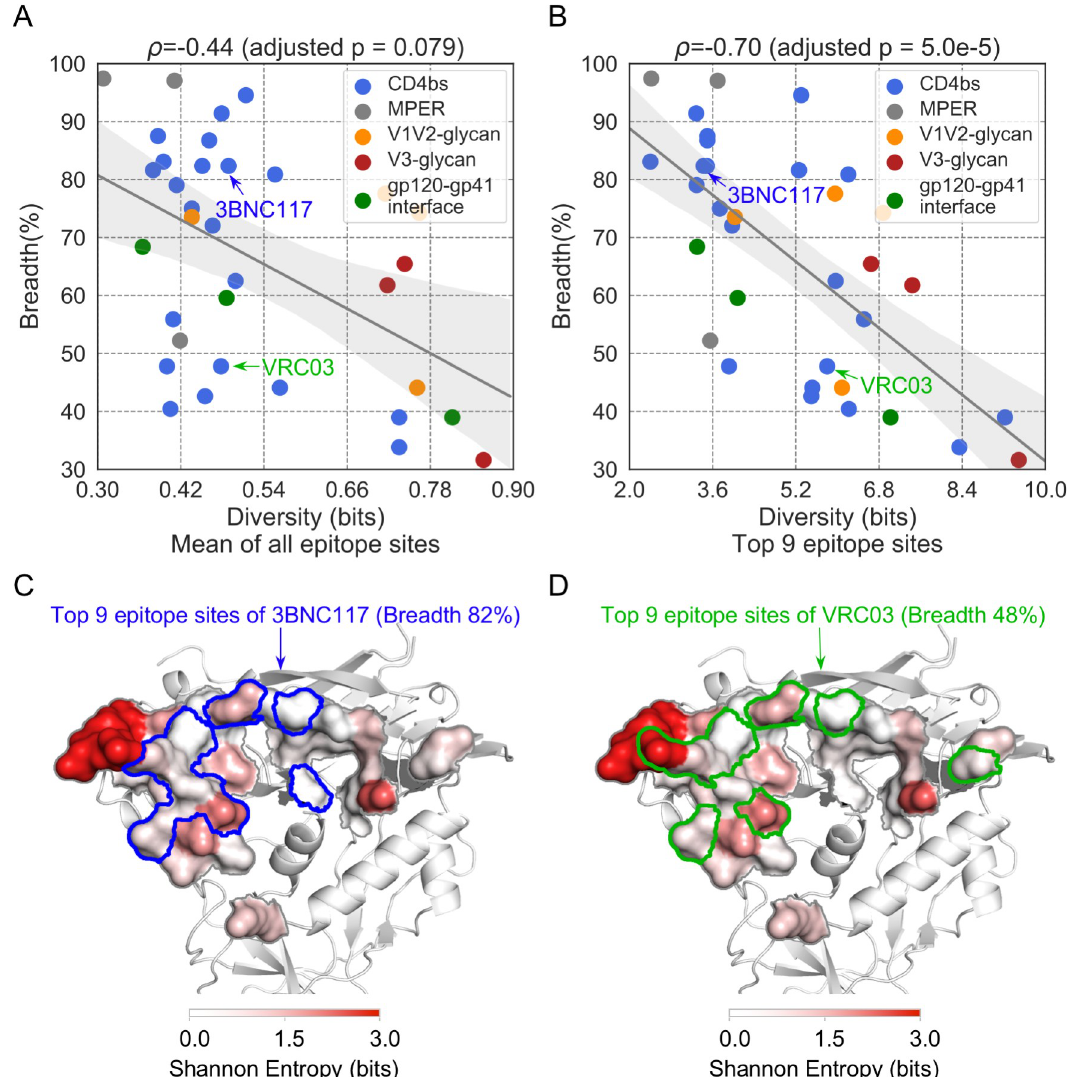
Fig 2. Conservation at key epitope sites was associated with neutralization breadth. Relationship between the neutralization breadth of Abs and (A) the mean diversity of all epitope sites (i.e., normalized for epitopes ranging from 8 to 36 sites) and (B) the top- nine epitope sites (ranked by the number of neighboring Ab residues). The 95% confidence interval of the linear regression line was determined by 1000 bootstrap replicates. The Abs 3BNC117 and VRC03 share similar epitopes but the epitope diversity based on their top nine sites (ranked by the number of neighboring Ab residues) was lower for 3BNC117 than that for VRC03; 3BNC117 was more focused on conserved epitope sites (C) than VRC03 (D) and its neutralization breadth was 34% higher than that of VRC03.